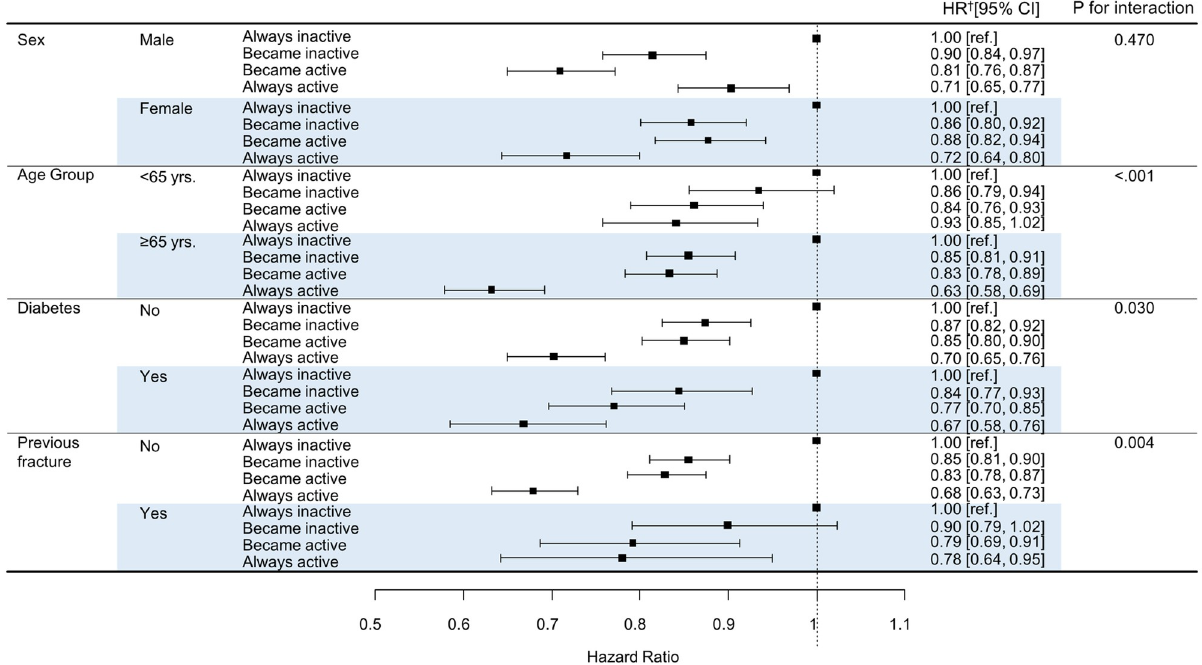
Fig 2. Associations between change in regular physical activity and risk of hip fracture by subgroup. †Model adjusted for age, sex, smoking status, alcohol consumption, income, body mass index, diabetes, and prior fracture. HR, hazard ratio; CI, confidence interval.